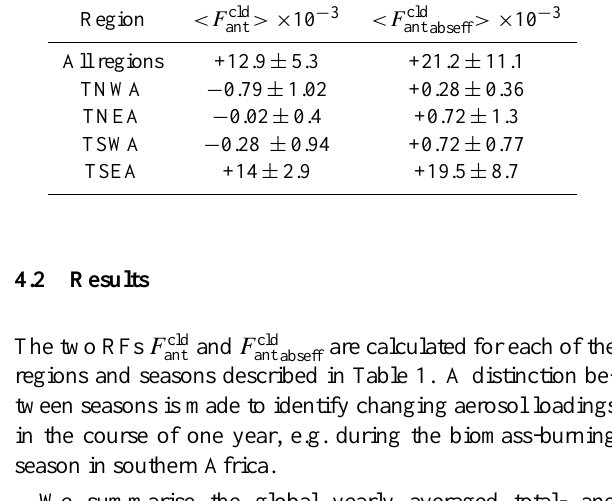
Table 3. Annual mean global anthropogenic aerosol RF at TOA